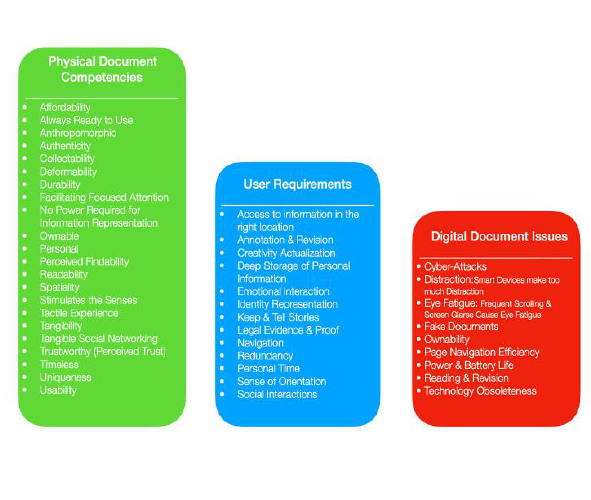
Figure 2. Human-Paper Interaction in the Digital Age Framework